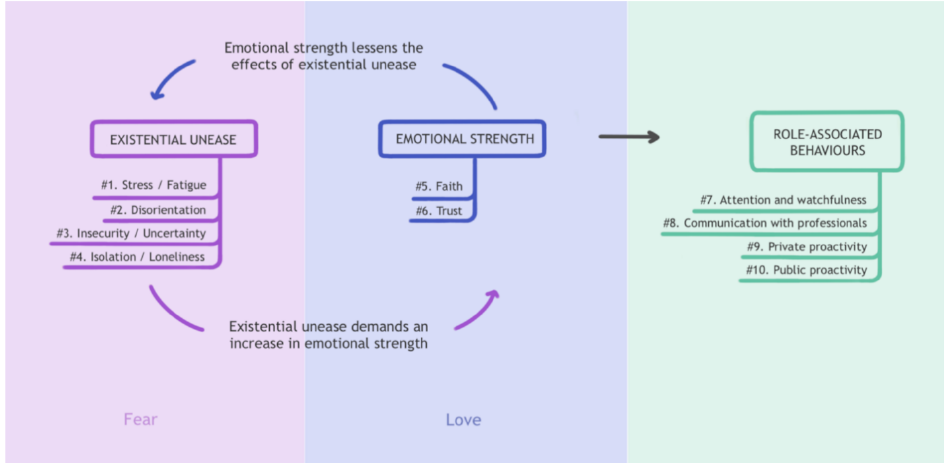
Figure 1. Flowchart of the parents’/caregivers’ role